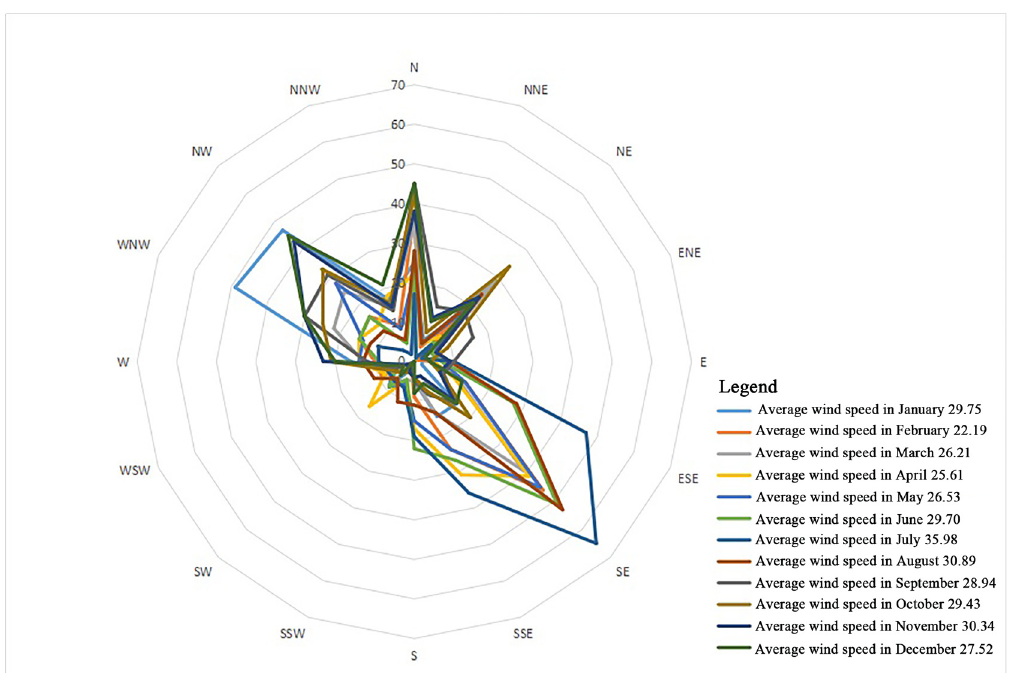
Figure A. Annual wind rose in Fuzhou (m/s) (2015–2019). Data from Fuzhou Climate Station. Figure A1. Annual wind rose in Fuzhou (m/s) (2015–2019). Data from Fuzhou Climate